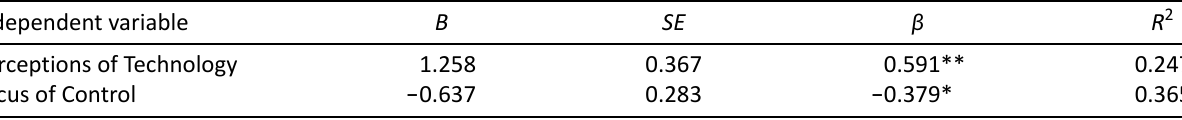
Table 6. Multiple regression in steps to predict differences in Familiarity With Concepts About Computers and the Internet. Independent